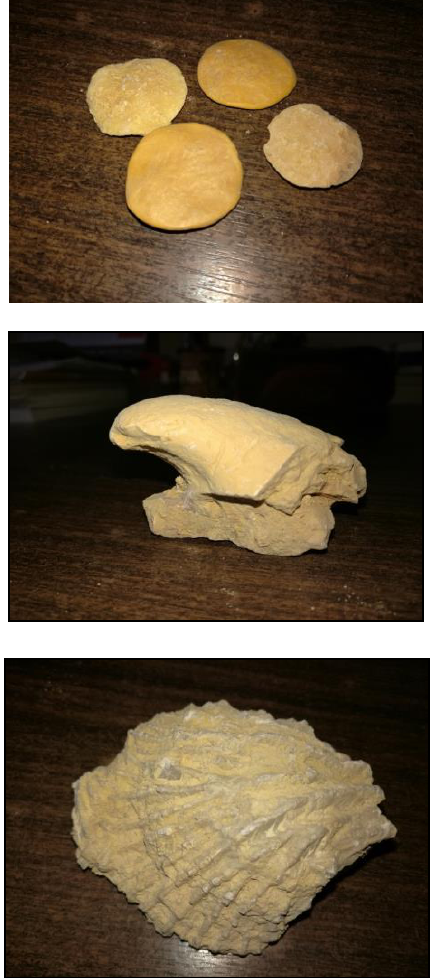
Figure 10: Different fossils record different facies and geologic ages in the Abu Roash area: a- nummilites gizahensis (, Eocene), b & c rudist bivalves, d- Rudist rudist bearing limestone (after Abdel-Gawad et al, 2011). A,b, and c are samples of fossils were collected during a field trip with students.